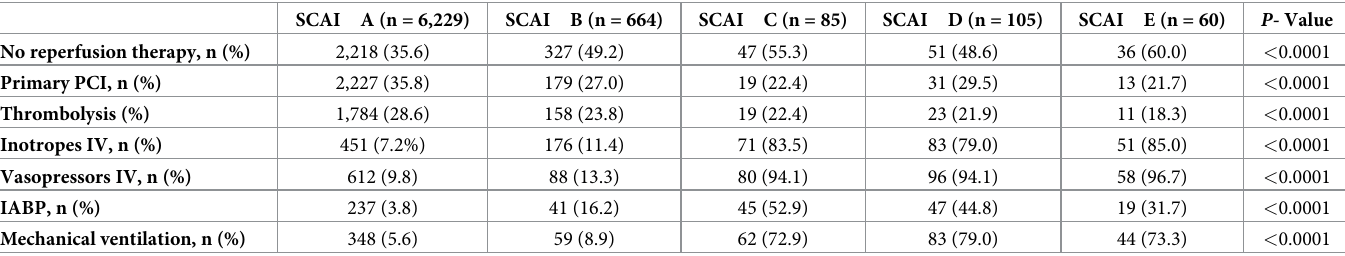
Table 3. Therapies during hospitalization of according to society for cardiovascular angiography and intervention cardiogenic shock